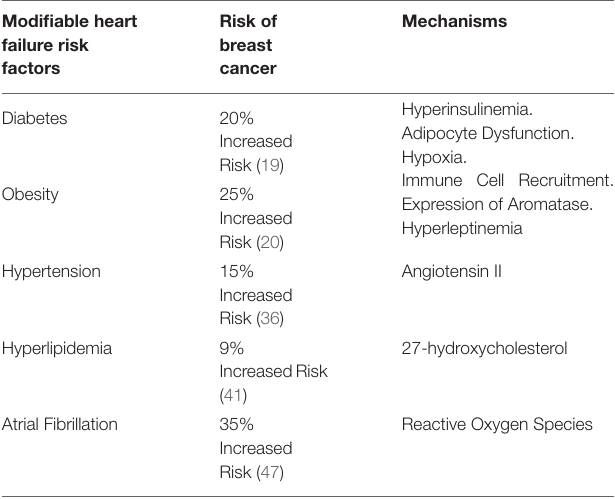
TABLE 1 | Impact of modifiable heart failure risk factors that increase risk for breast cancer and potential underlying